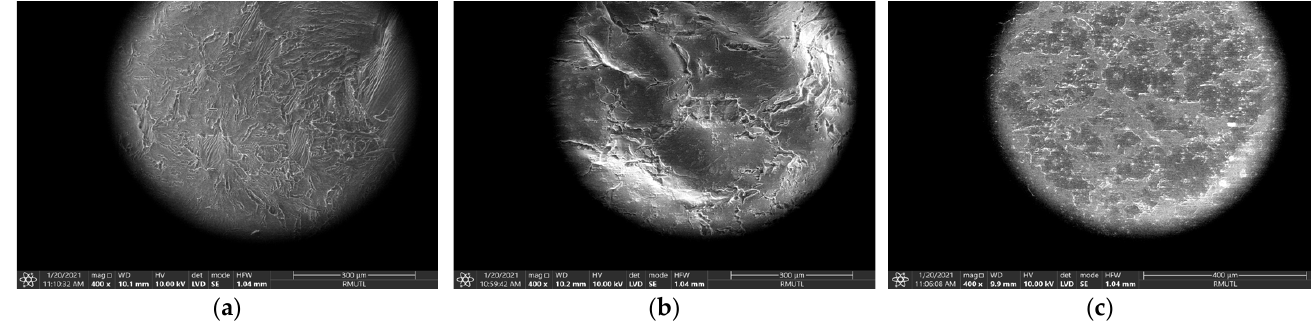
Figure 2. Scanning electron micrograph of turmeric extracts using UAE ( a ), MAE ( b ) and TDE ( c ).